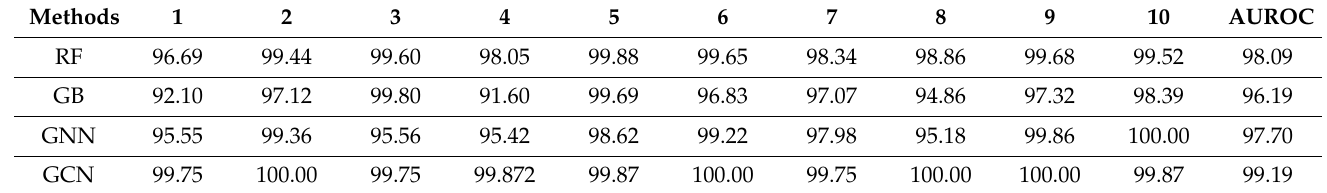
Table 5. Ten-fold cross validation accuracies for link prediction using RF, Gboost, and GNN in DDKG.